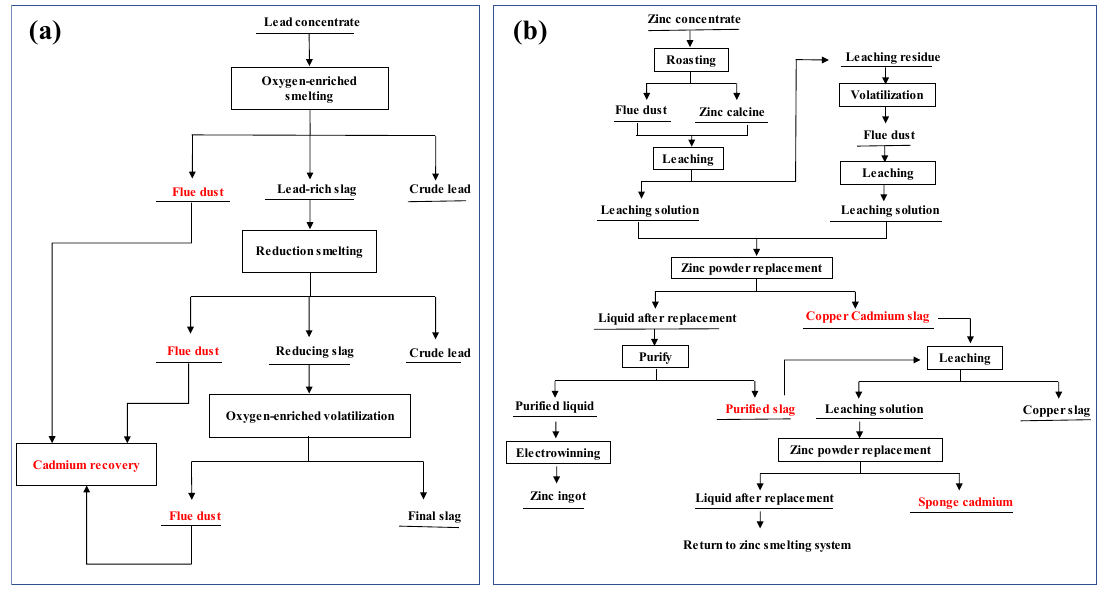
Figure 3. ( a ) Pb smelting process; ( b ) Zn smelting process.